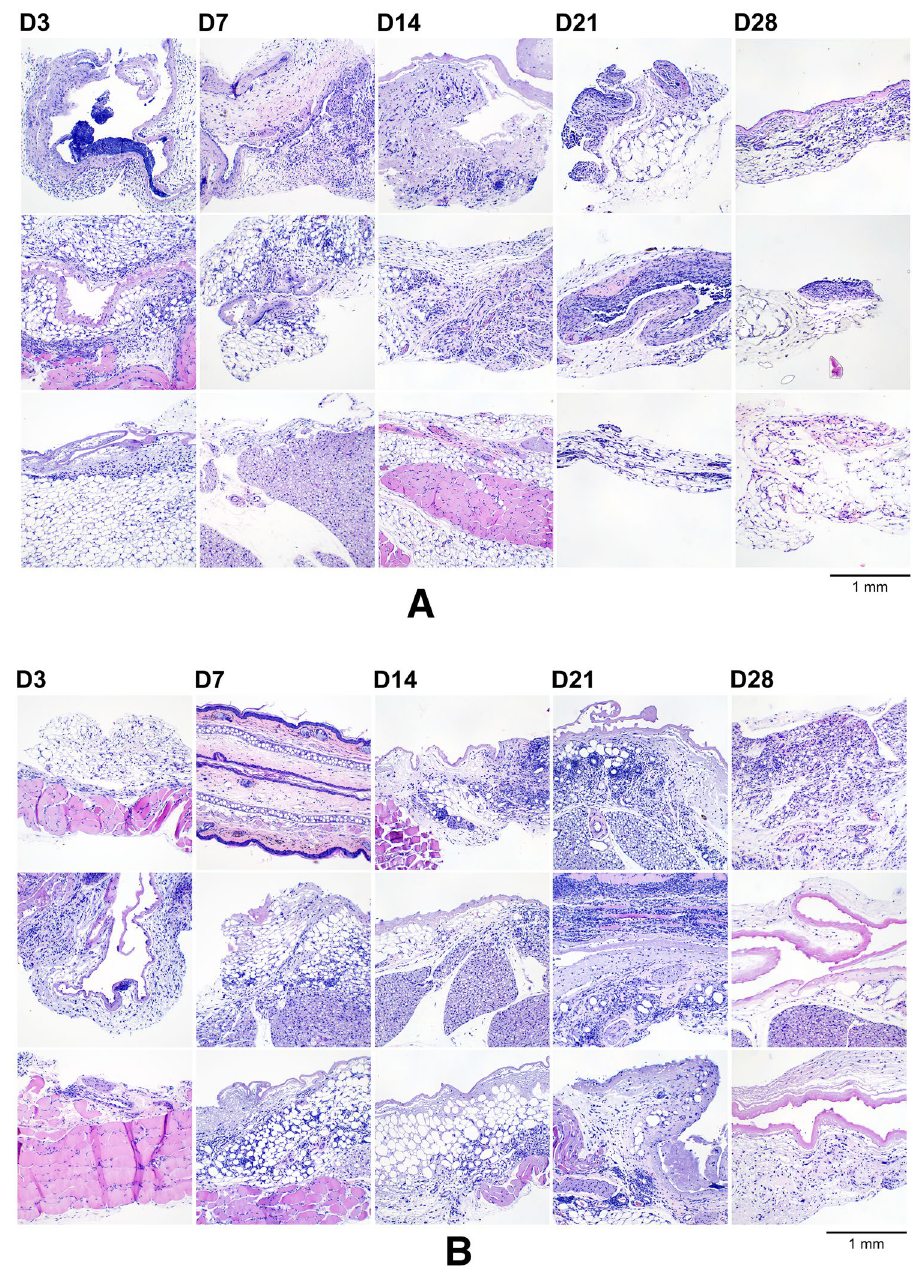
Figure 12. ( A ) Dermal tissues collected adjacent to the TAF implant from the low-releasing group, aldehyde- fixed, paraffin-embedded, sectioned, and H&E-stained. The specimens span the 28-day period where the implants were in place and representative samples from all animals ( N = 3 per timepoint) are included; D3, D7, D14, D21, and D28 indicate tissue specimens collected with the TAF implant in place at study days 3, 7, 14, 21, and 28, respectively. Scale bar, 1 mm. ( B ) Dermal tissues collected adjacent to the TAF implant from the high-releasing group, aldehyde-fixed, paraffin-embedded, sectioned, and H&E-stained. The specimens span the 28-day period where the implants were in place and representative samples from all animals ( N = 3 per timepoint) are included; D3, D7, D14, D21, and D28 indicate tissue specimens collected with the TAF implant in place at study days 3, 7, 14, 21, and 28, respectively. Scale bar, 1